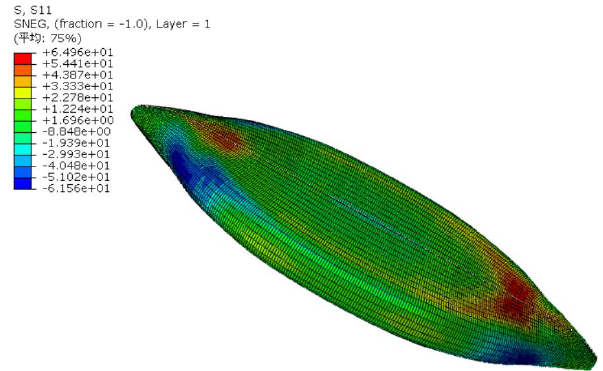
Figure 13: Distribution of circumferential